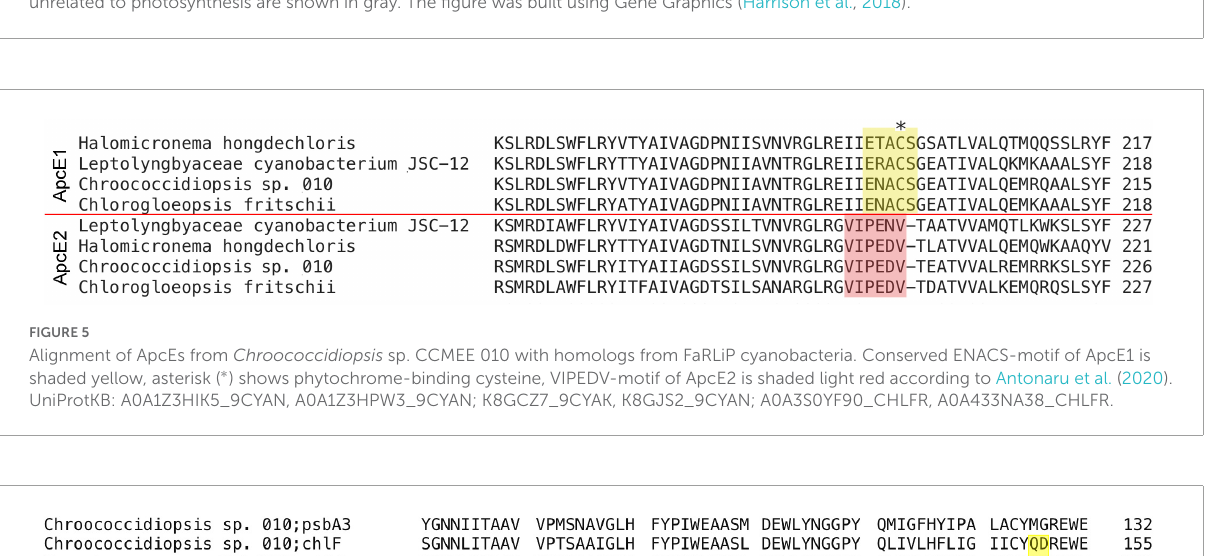
FIGURE4 Far-red genes of Chroococcidiopsis sp. CCMEE 010. Color-coding for genes: psa genes for subunits of PSI (yellow); psb genes of PSII (green); apc genes of PBS (blue); rfp genes for the knotless phytochrome (RfpA) and response regulators RfpB and RfpC (red); genes presumed unrelated to photosynthesis are shown in gray. The figure was built using Gene Graphics (Harrison et al., 2018).